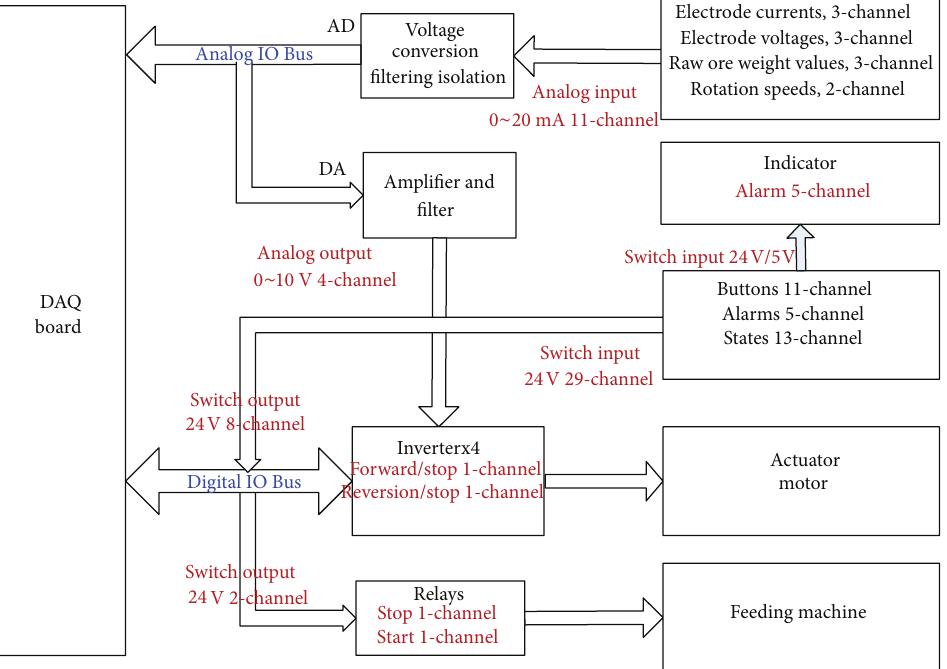
Figure 4: Functional structure of signal processing board.